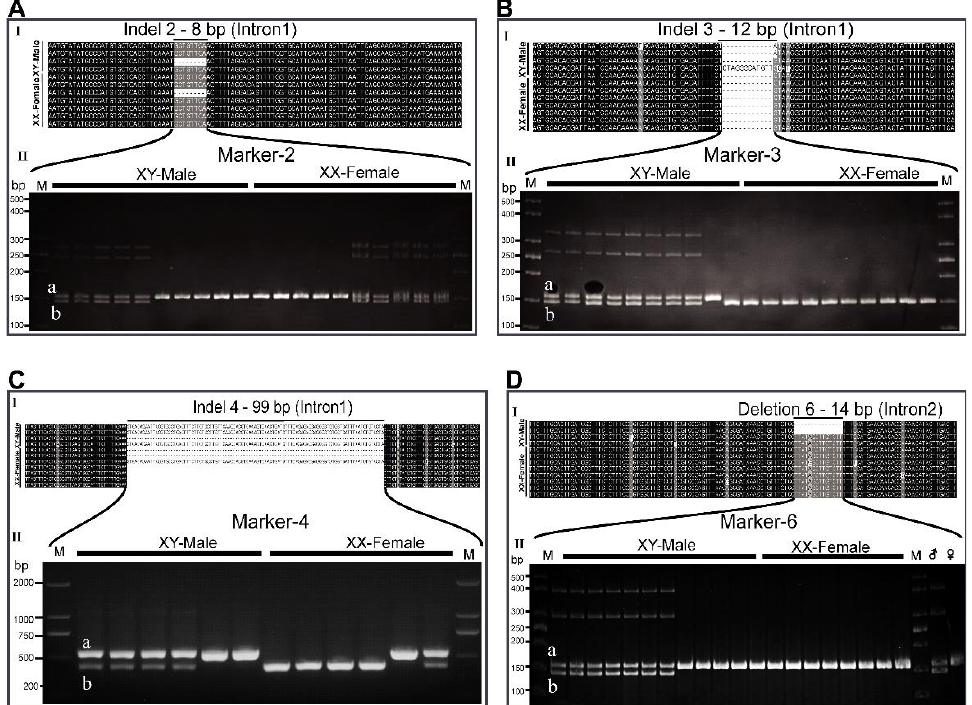
Figure 4. Dmrt2a sequence analysis in spotted scat. ( AI ) A 8 bp indel in intron 1 of male and female sequence ( AII ) PAGE gel with primers spanning the indel region was heterozygous (double bands) and homozygous (single bands) in both males and females. ( BI ) A 12 bp indel in intron 1 of the male sequence. ( BII ) PAGE gel shows that most males are heterozygous (double bands), while all females are homozygous (single bands). ( CI ) A 99 bp indel in intron 1 of male and female sequences ( CII ) Agarose gel electrophoresis reveals heterozygosity and homozygosity in males and females. ( DI ) A 6 bp deletion in intron 2 of the male sequence. ( DII ) PAGE gel shows that most males are heterozygous while all females are homozygous. The total number of fish tested with these markers is shown in Tables 1 and 2. a; upper/longer bands, b; lower/shorter bands.